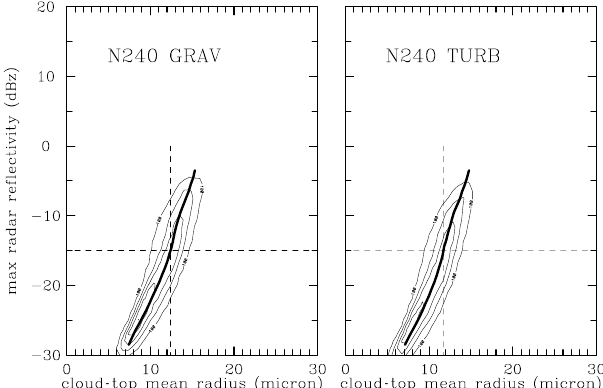
Figure 9. Joint histograms of the maximum radar reflectivity in the model column vs. the cloud-top mean radius of cloud droplets for GRAV and TURB N240 cases. The contours mark the data point density (with contour interval of 200 starting at 100) and the thick solid lines depict the mean relationship implied by the histogram. Dashed horizontal line represents the − 15dBz threshold and the dashed vertical line marks the mean radius corresponding to the − 15dBz threshold.